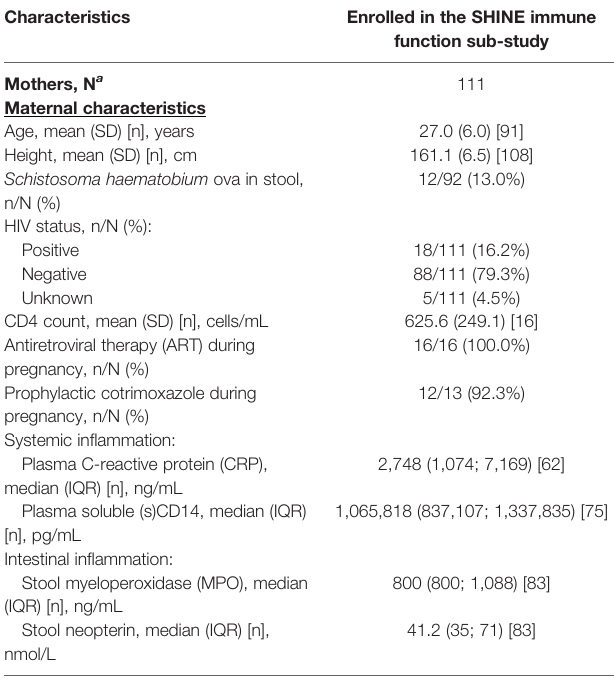
TABLE 3 | Baseline household and maternal characteristics of the SHINE immune function sub-study cohort. Characteristics Enrolled in the SHINE immune function